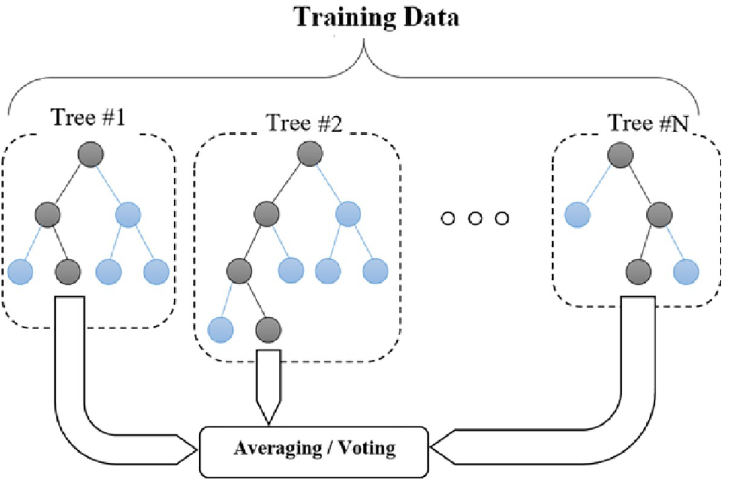
Fig 4. The schematic architecture of an RF